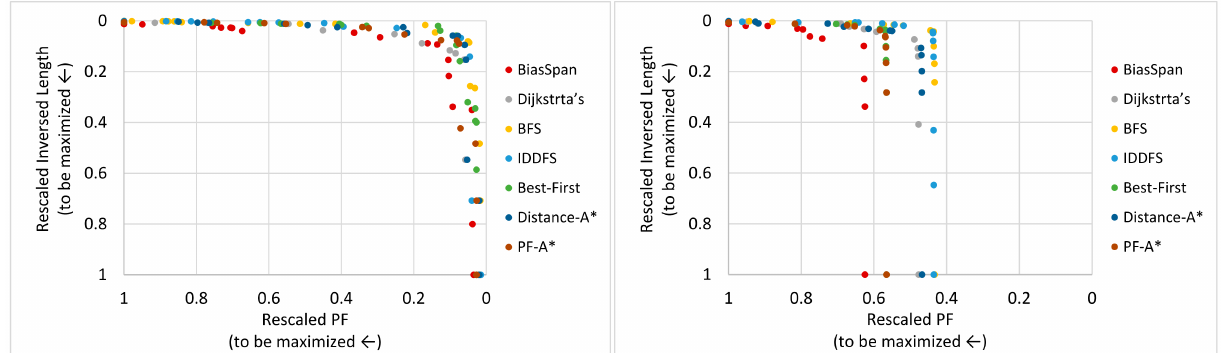
Figure 13. Examples of the nondominated solutions (Pareto frontier) among all generated solutions in PF and inversed length for Chicago ( left ) and Tainan ( right ) dataset. Where both objectives are normalized to the maximum value of 1, and are to be maximized. For the hypervolume calculation, the (0, 0) is selected as the reference